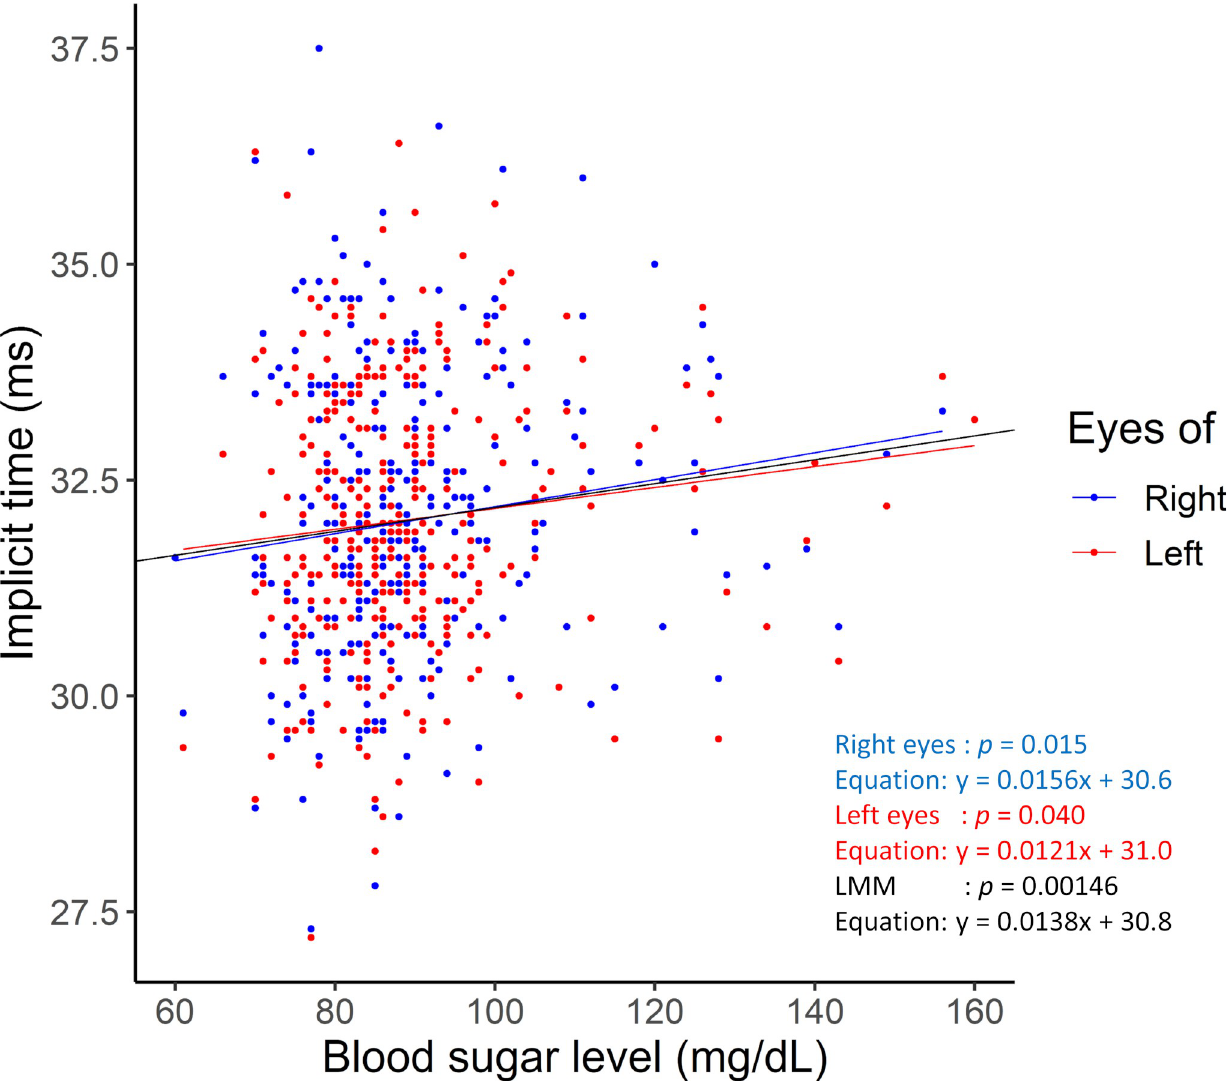
Fig 2. Relationship between blood sugar level and implicit times of the fundamental components of the RETeval flicker ERGs. The blood sugar levels are plotted against the implicit times of the fundamental component of the RETeval flicker ERGs. In the univariable linear regression analysis between the blood sugar level and implicit times of the fundamental components of the RETeval flicker ERGs, the p = 0.015 in the right eyes (blue plot and approximate line: y = 0.0156x + 30.6), p = 0.040 in the left eyes (red plot and approximate line: y = 0.0121x + 31.0), and p = 0.00146 in the linear mixed effects model (black approximate line: y = 0.0138x + 30.8). LMM, linear mixed effects model.